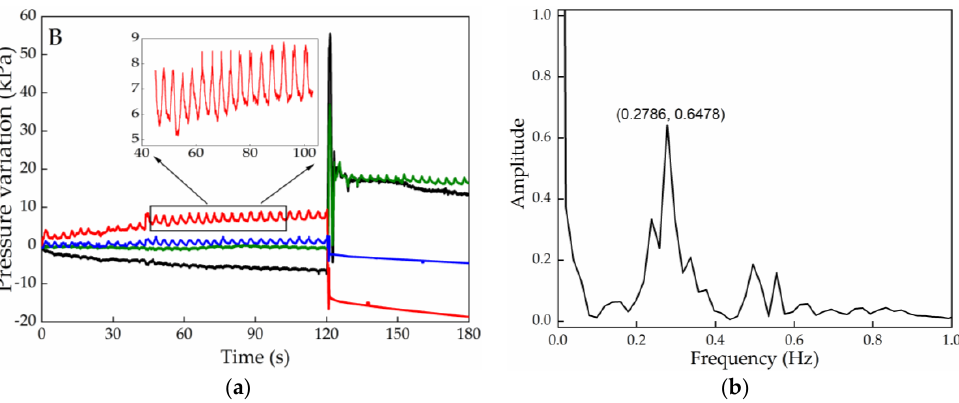
Figure 8. ( a ) Pressure variation registered in different cells, highlighting the SL cell results, during the pressure relief exercise B; ( b ) Fourier transform applied to the optical signal detected by the SL and highlighted in Figure 8a, for wheelchair user breathing rate